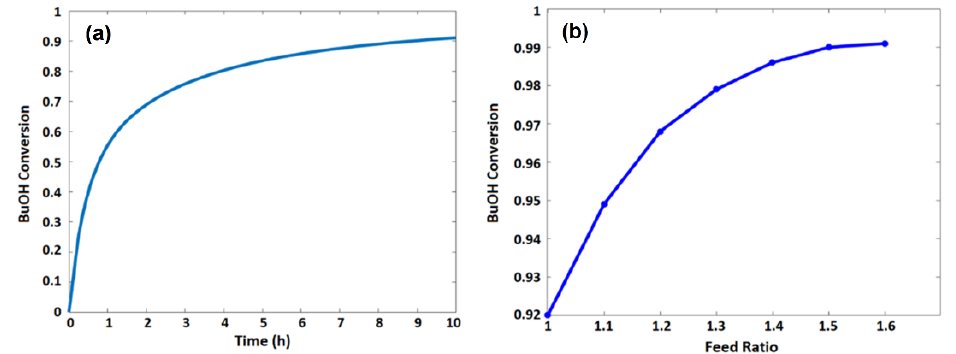
Figure 5. n -Butanol conversion as a function of ( a ) the residence time of the membrane reactor and